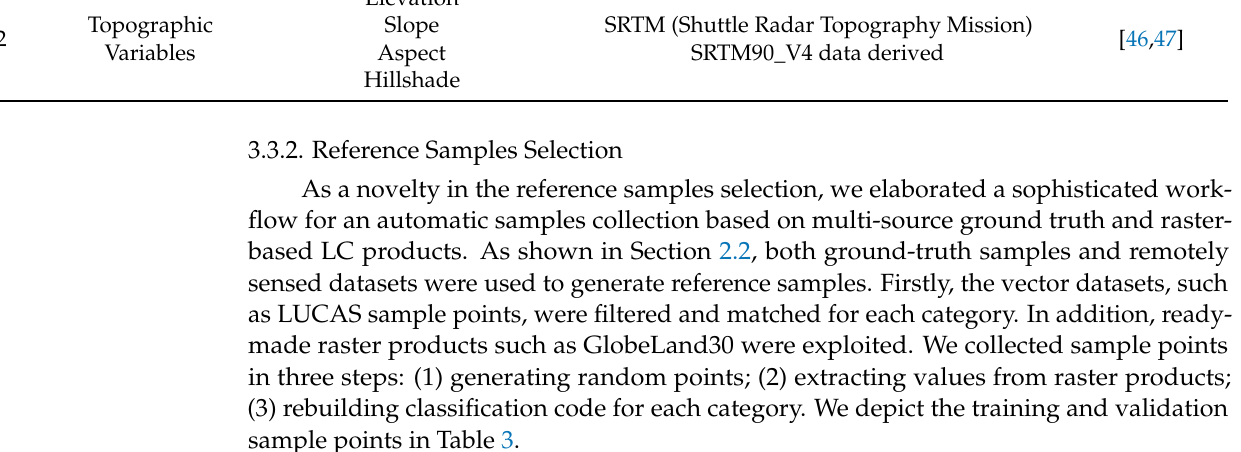
Table 3. Number of used training sample points (T) and validation sample points (V) of each category for six cities in